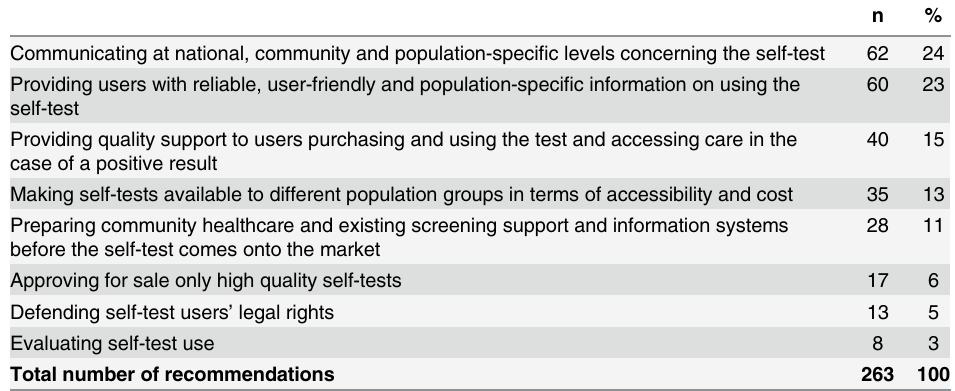
Table 2. Number of recommendations for each major theme.